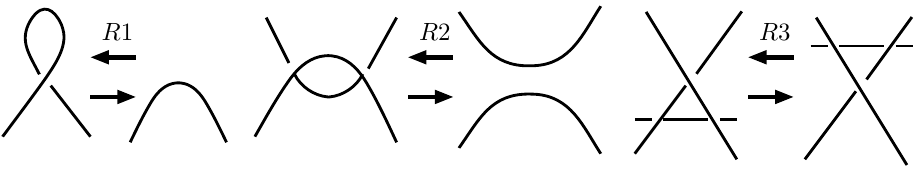
Fig. 4. Three types of Reidemeister moves.